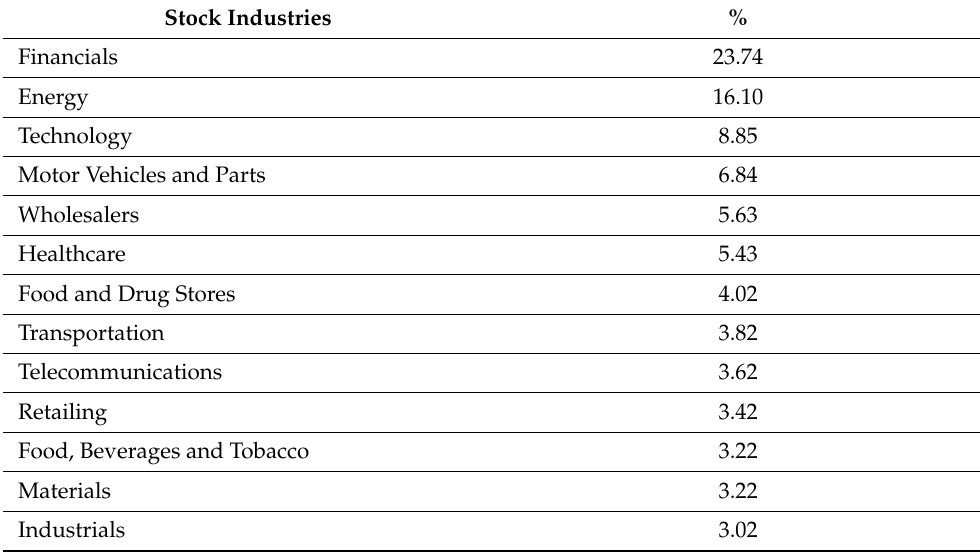
Table 2. Industries and the number of companies per